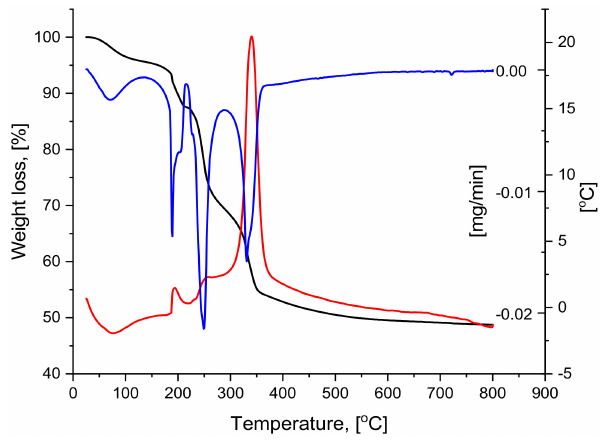
Figure 4. Thermal analysis (TG / DTG / DTA) for silica-iron xerogel composite material.